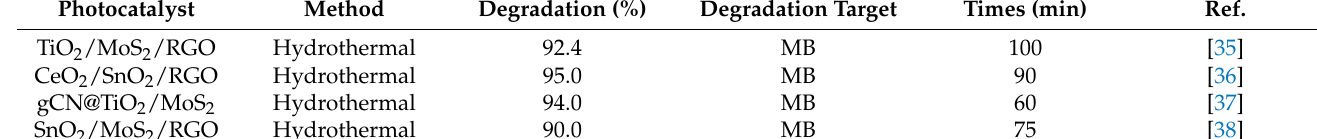
Table 1. Comparison of previously reported catalysts with our nanohybrid catalyst.